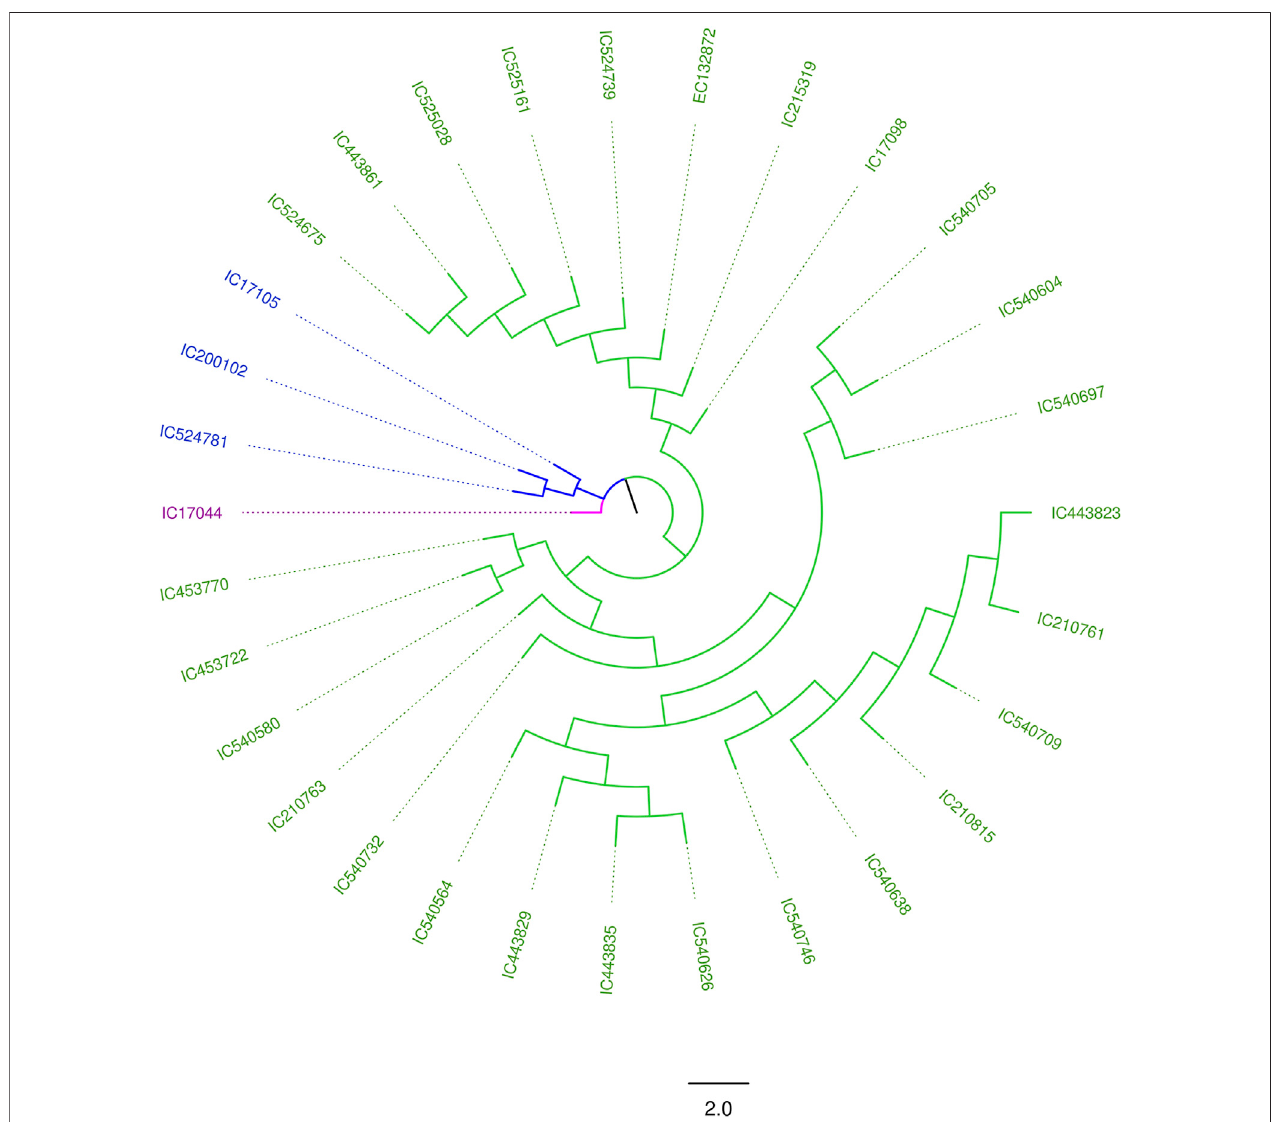
FIGURE 6 | NJ tree of the east coast mini core